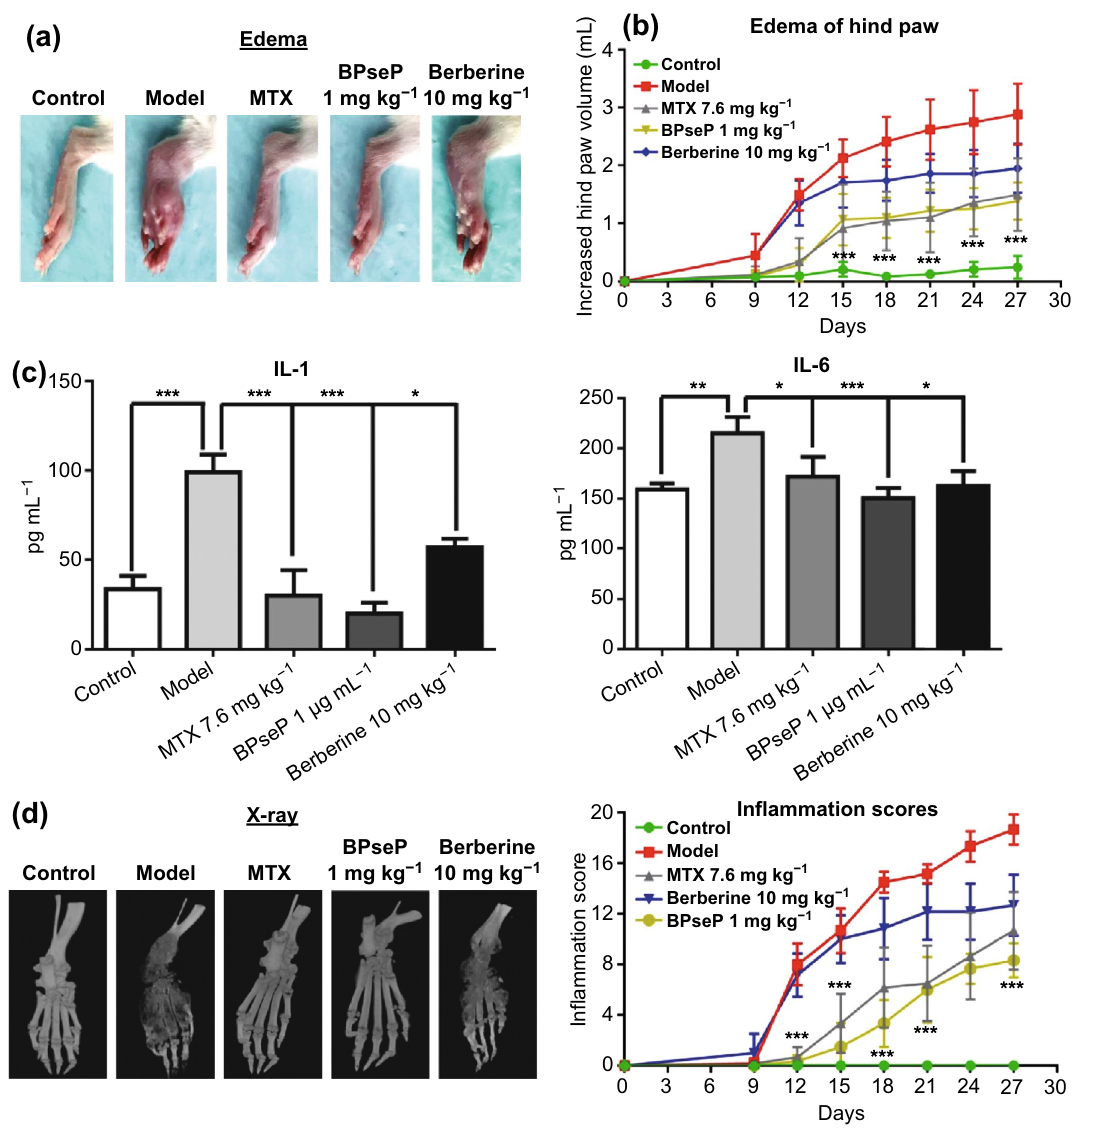
Fig. 7 a , b BPseP treatment acquired a significant regression in edema of the hind paw. c BPseP remarkably inhibited the secretions of IL‑1 and IL‑6. d The results of X‑ray imaging showed that BPseP is able to protect the joint bone from destruction induced by AIA. Data were analyzed as the mean ± SEM for triplicate individual experiments (* P < 0.05, ** P < 0.01, *** P <